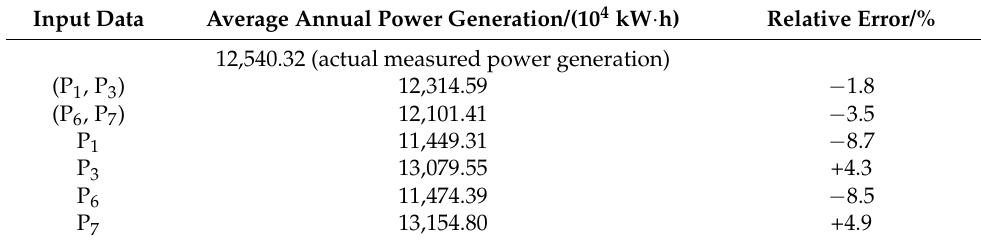
Table 4. Annual energy production and error analysis of wind